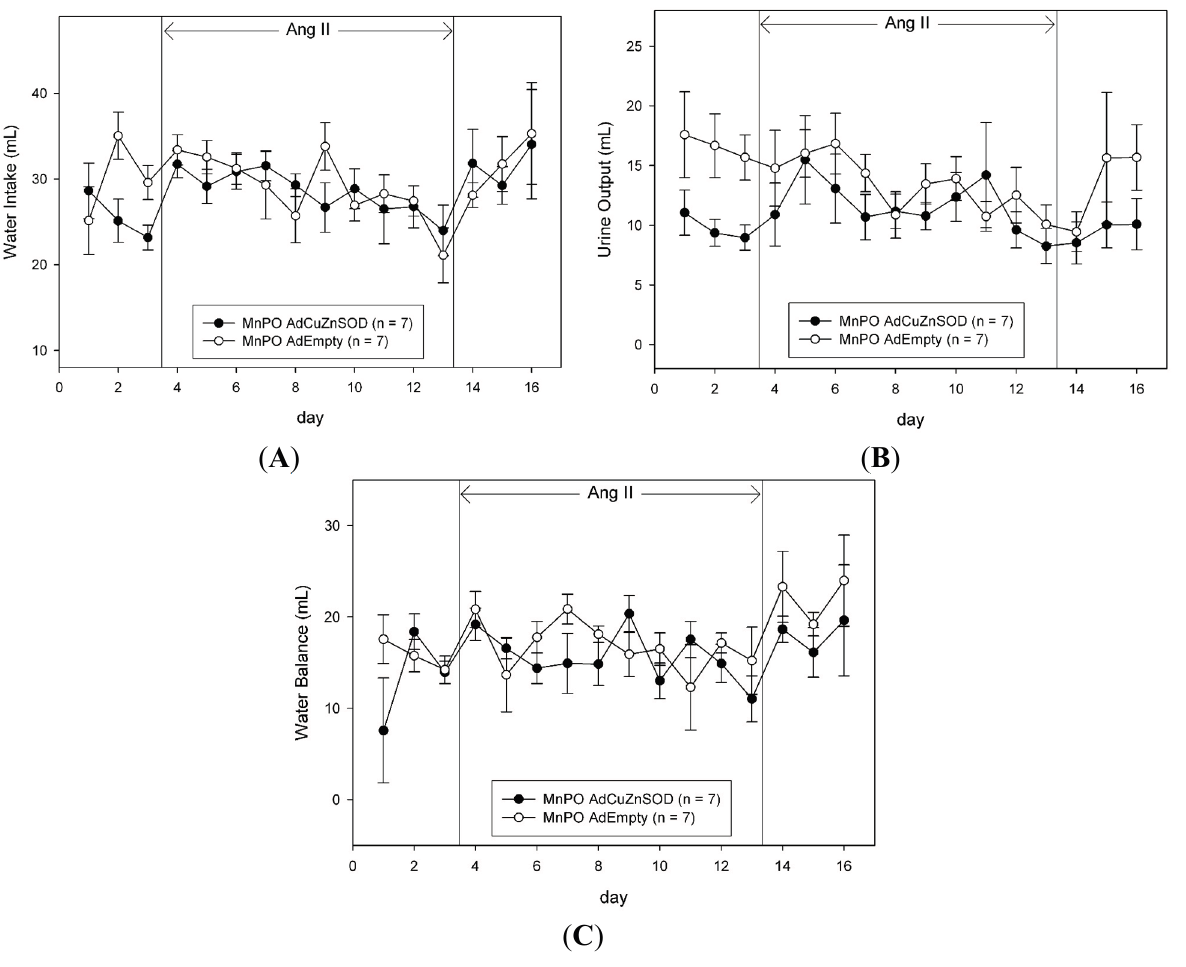
Figure 4. Average 24-h water intake ( A ); urine output ( B ); and water balance ( C ) during saline infusion (3 days of control and recovery period) and 10 days of AngII infusion in rats that were MnPO injected with AdCuZnSOD or